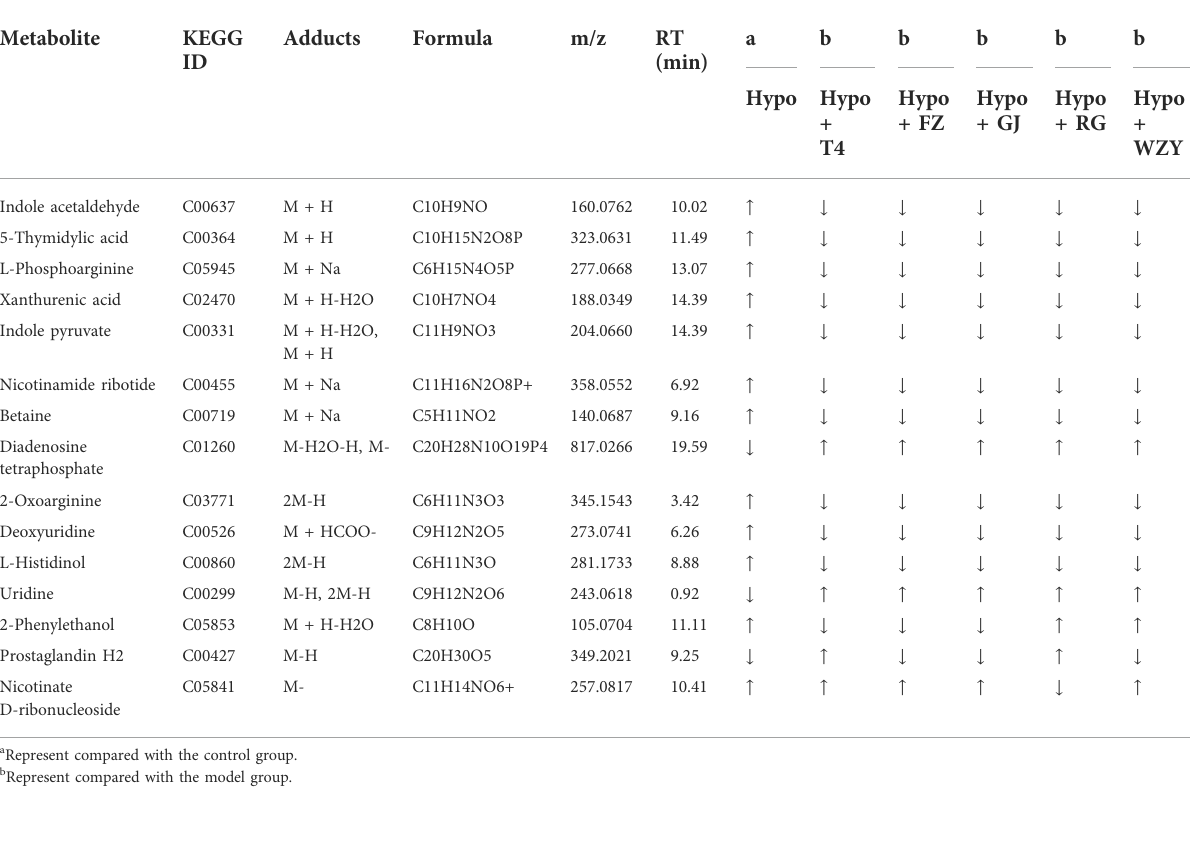
TABLE 1 The biomarkers are affected by the four typical “ hot ” property herbs. Metabolite